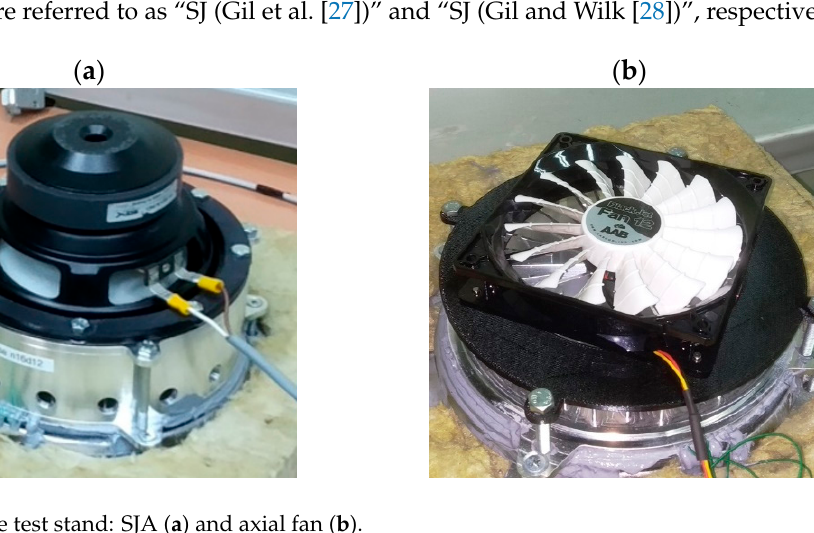
5 of 17 Figure 2. Schematic diagram of the experimental setup: 1—loudspeaker, 2—heat sink with outer ring, 3—heater, 4—insulation. The air at atmospheric pressure was used as a working fluid. The ambient temperature in the laboratory was controlled with an air conditioning system. During the